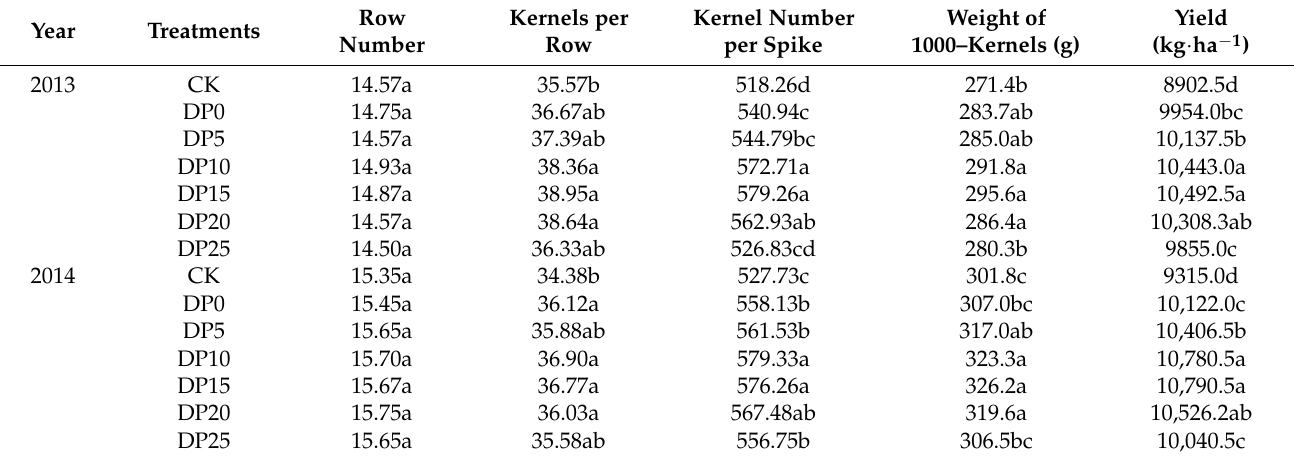
Table 1. Effects of different basal application depths of controlled-release urea on summer maize yield and yield